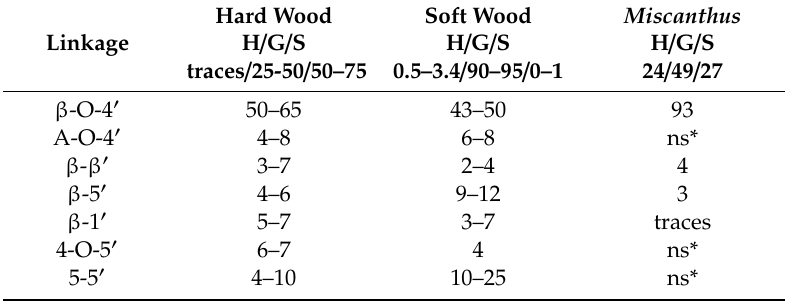
Table 1. Abundance of linkages in lignins of soft and hard wood and Miscanthus grasses, including KOH-extractable and non-KOH-extractable, in percentages. Reprinted from [27] under open access license.